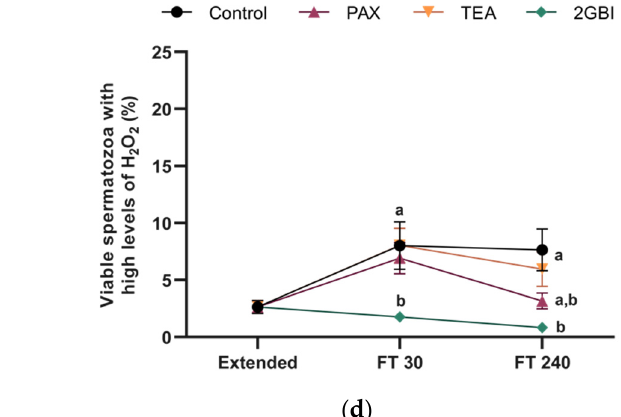
and peroxide levels expressed as percentages of viable spermatozoa DCF + /PI − , ( c , d ) in extended and frozen–thawed